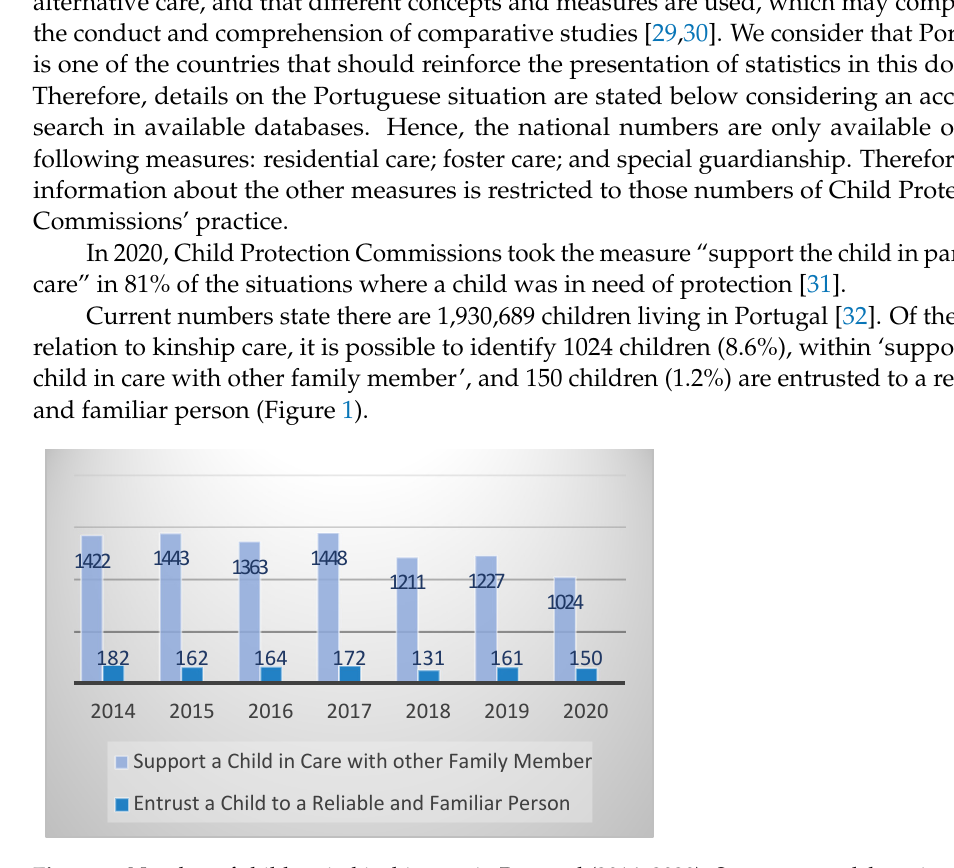
Figure 1. Number of children in kinship care in Portugal (2014–2020). Source: own elaboration based on CNPDPCJ [31].